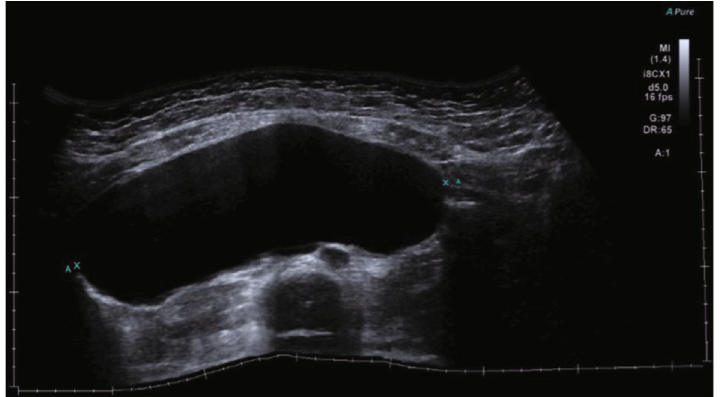
Figure 1: Transverse ultrasound view of the right adnexa, demonstrating the cyst. Note its homogenous